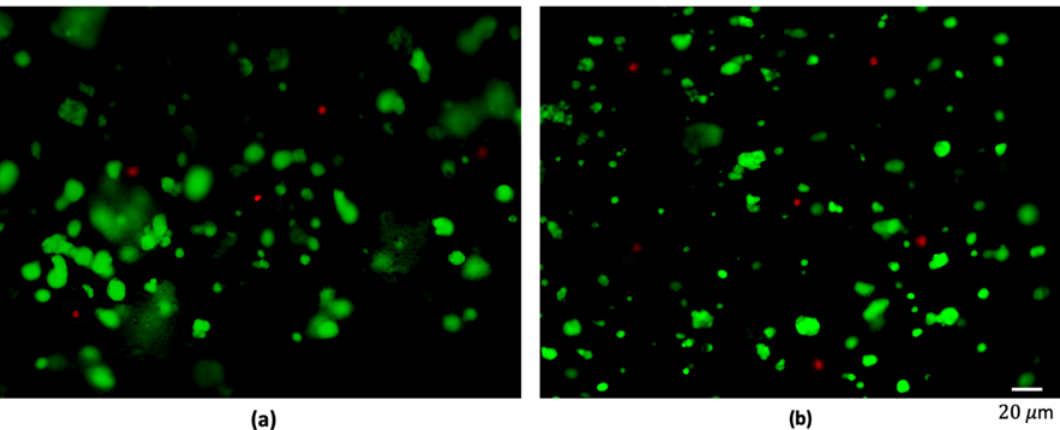
Figure 3. Live / dead staining on MDA-MB-231 cultured in channel-based alginate ( a ) and fibrin ( b ) hydrogels.